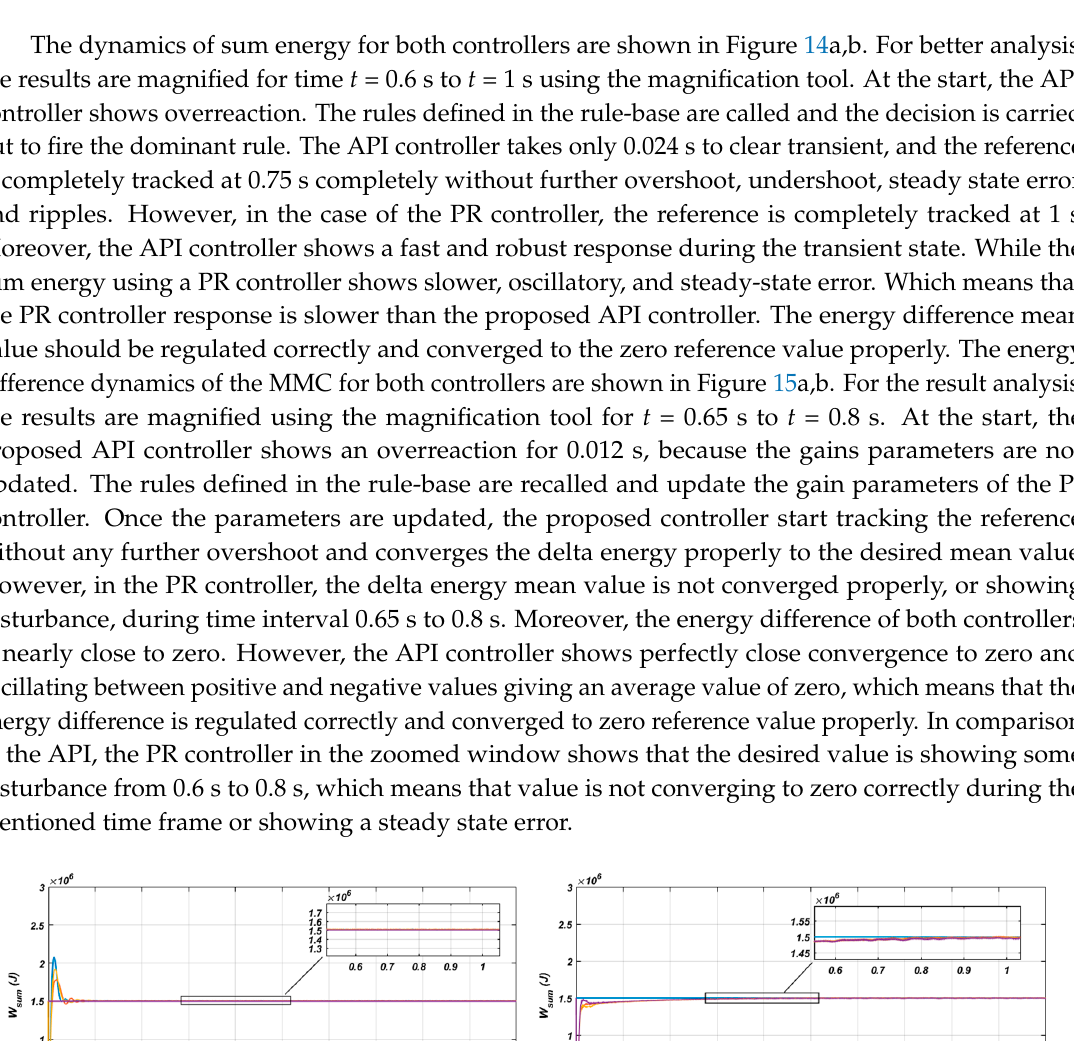
Figure 13. ( a ) Capacitor voltage of a lower arm using the API controller; ( b ) capacitor voltage of a lower arm using the PR controller.